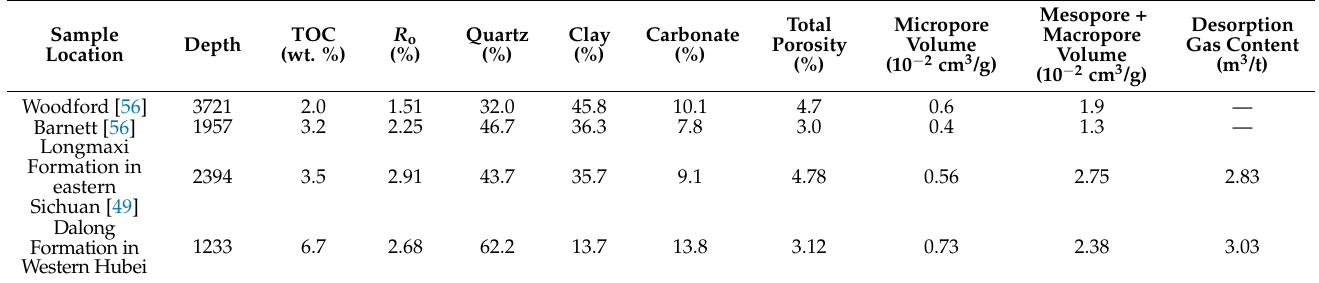
Table 3. Shale reservoir characteristics of the Dalong Formation in Western Hubei compared to other typical shale